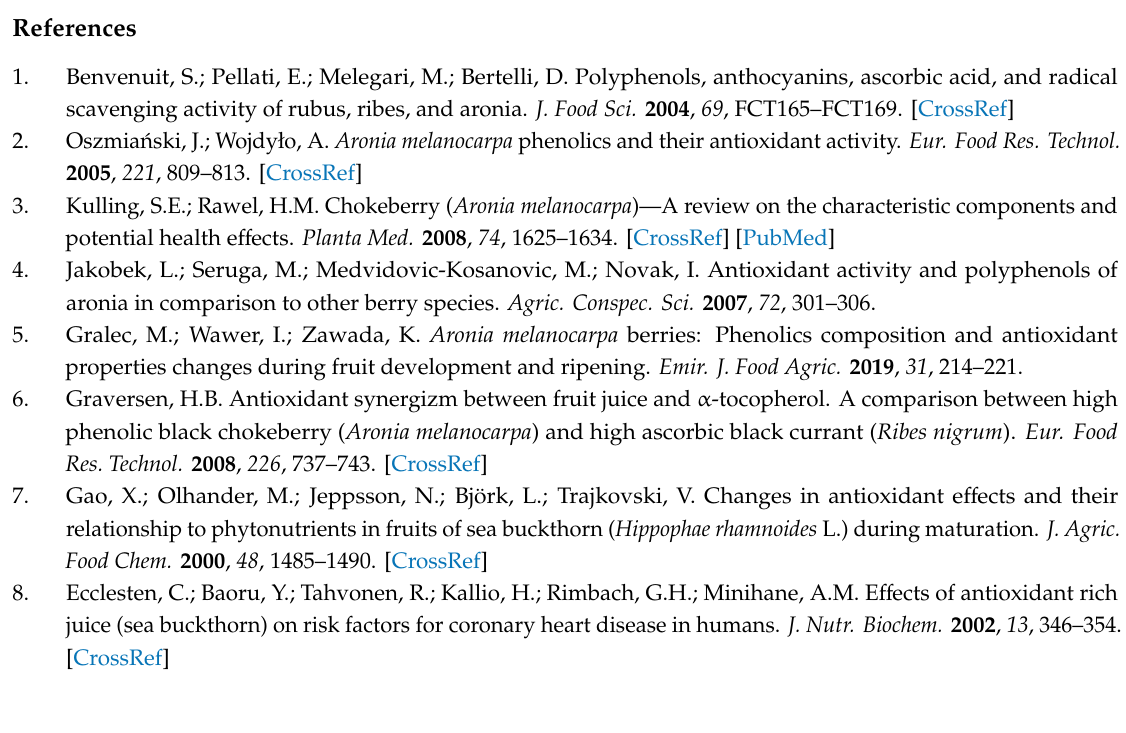
Table S1: F -test values of analysis of physicochemical characteristic of fruit-herbal functional beverages presented in Table